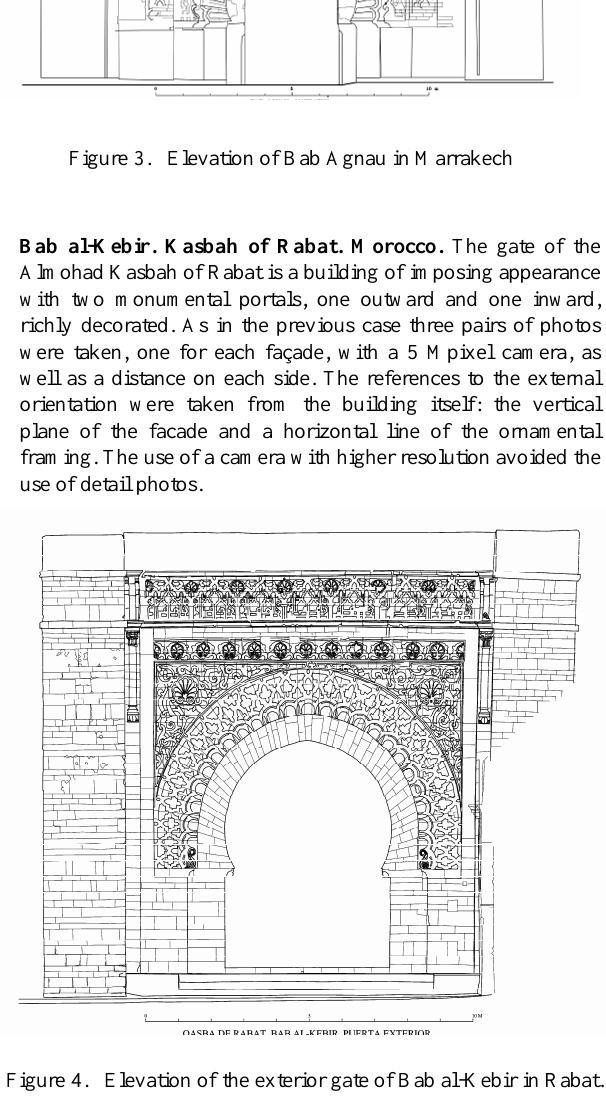
Figure 4. Elevation of the exterior gate of Bab al-Kebir in Rabat.